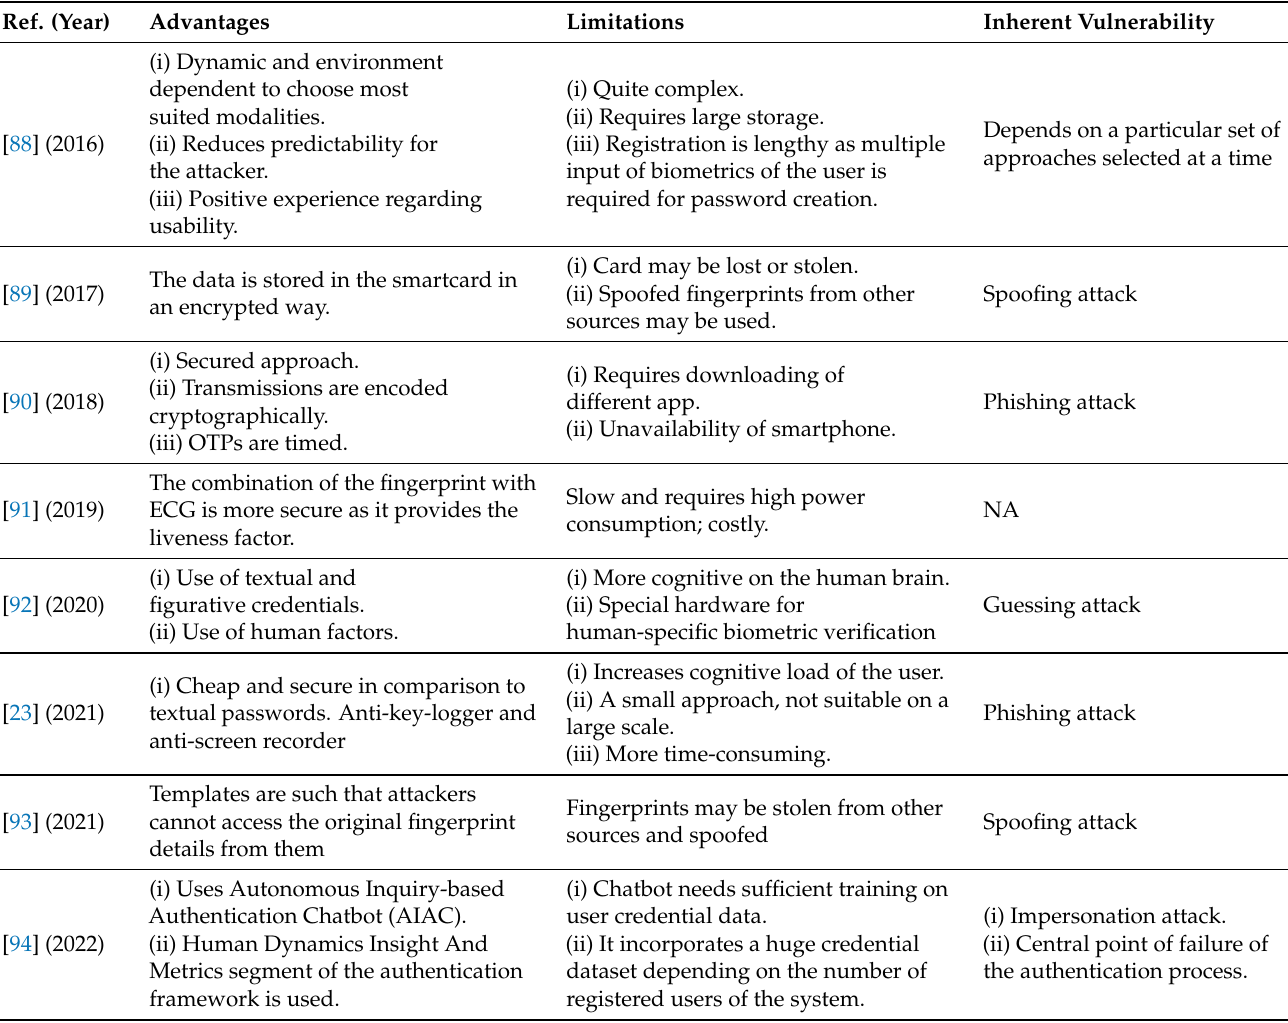
Table 4. Comparison of various MFA Approaches and Inherent